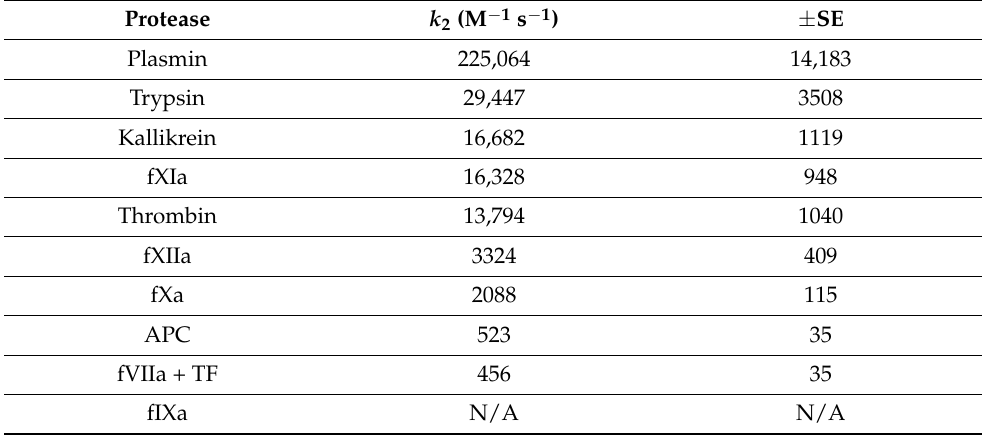
Figure 2. Formation of covalent complexes between Iripin ‐ 8 and serine proteases. Iripin ‐ 8 and selected serine proteases were incubated for 1 h and subsequently analyzed for complex formation by reducing SDS ‐ PAGE. Protein separation differs between ( A , B ) due to the use of gels with different polyacrylamide contents. Gels show the profile of Iripin ‐ 8 serpin alone, various serine proteases alone, and proteases incubated with Iripin ‐ 8. Complex formation between fVIIa and Iripin ‐ 8 was tested in the presence of tissue factor (TF) at an equimolar concentration. Covalent complexes between Iripin ‐ 8 and protease are marked with a red arrow. N: native Iripin ‐ 8, C: cleaved Iripin ‐ 8. Table 1. Inhibition rate of Iripin ‐ 8 against selected serine proteases.